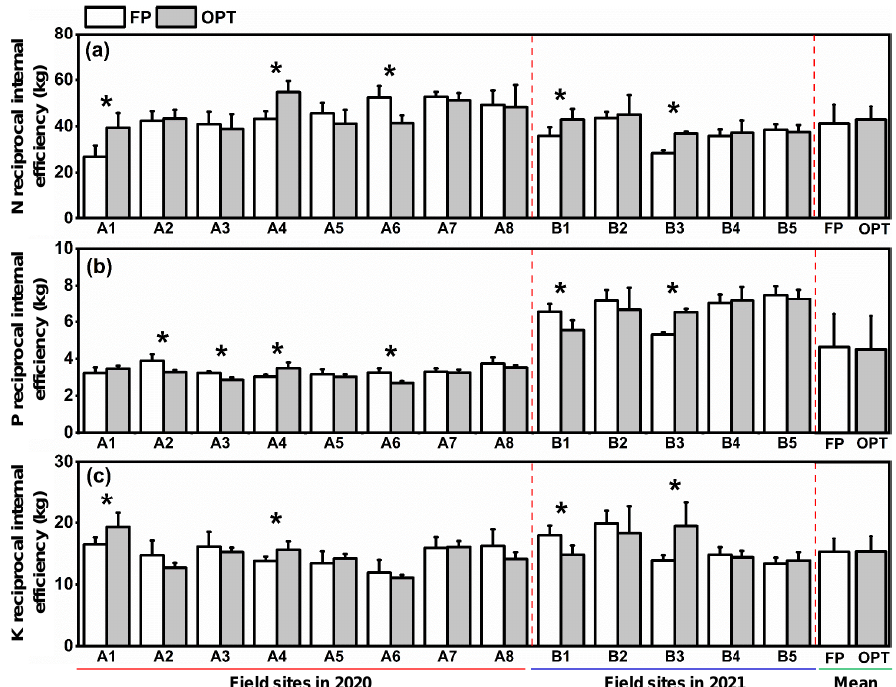
Figure 5. Requirements of N ( a ), P ( b ), and K ( c ) to produce 1000 kg pod yield of peanuts (reciprocal internal efficiency (RIE) under different treatments. FP: farmers’ practice fertilization; OPT: optimized fertilization. A: experiment in 2021; B: experiment in 2022. Tentacle lines on the bars are standard deviation. Asterisks (*) on the bars indicate a significant difference at P < 0.05 between fertilization treatments for the same field site.